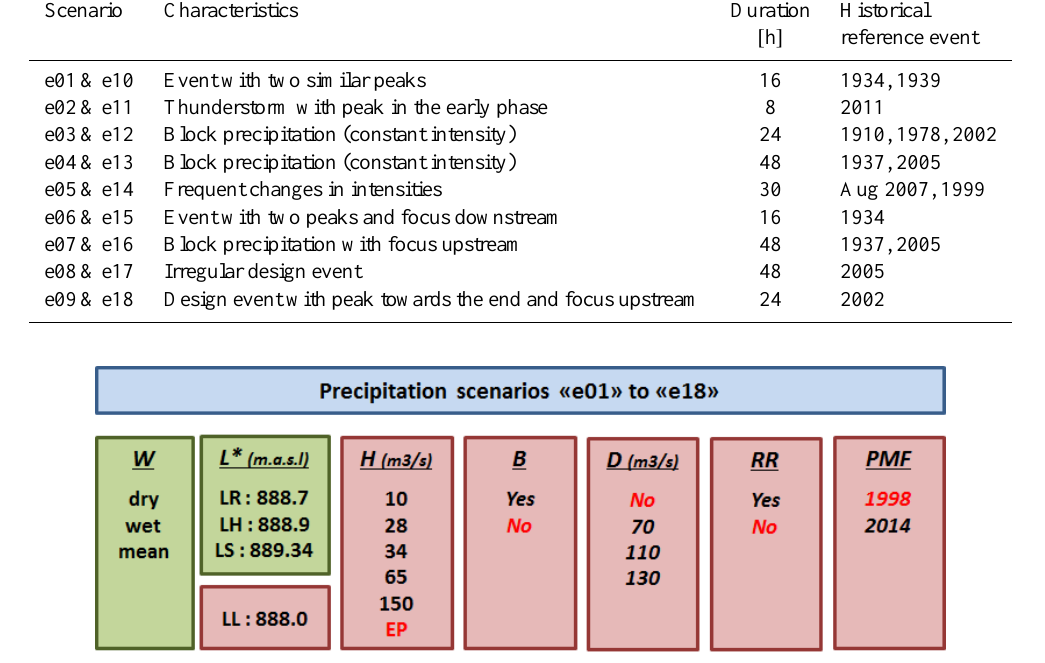
Figure 3. Schematic representation of the tested combinations of precipitation scenarios (blue, Table 1), antecedent hydrological conditions (green) and flood management options (magenta, Sect. 3). The bold red flood management options represent the current situation. Some of the labels are also visualized in Fig.